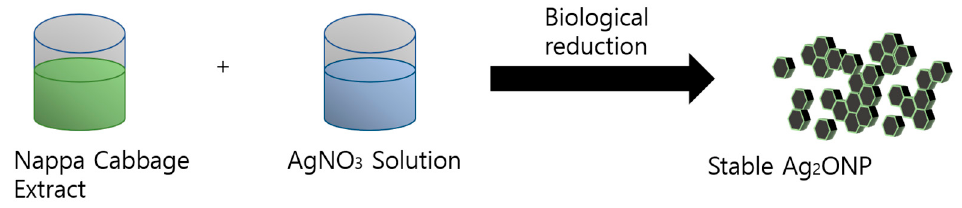
Figure 10. Schematic diagram of biological synthesis of Ag 2 ONP.